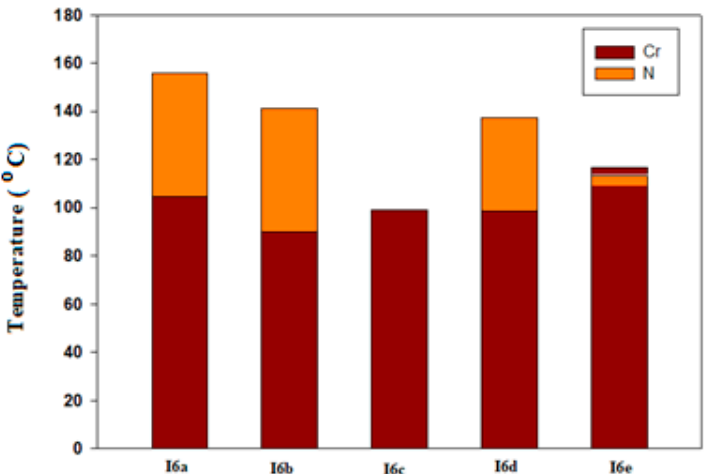
Cr-N = transition from solid to the nematic phase. N-I = transition from nematic to the isotropic liquid phase. * monotropic phase.